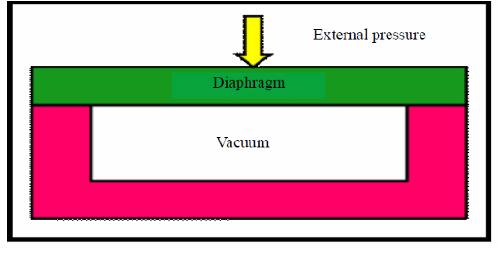
Fig. 2 Schematic representation of absolute pressure sensor.